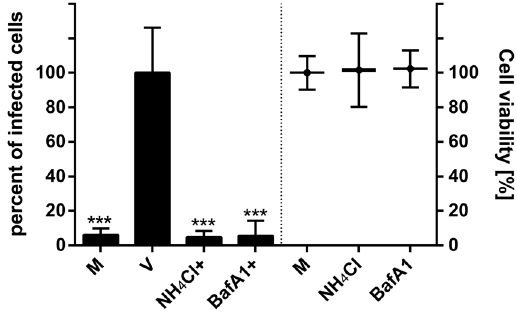
Figure 1. Inhibition of endosomal acidification with NH 4 Cl or bafilomycin A1 inhibits HCoV-OC43 infection in HCT-8 cell line. The infection efficiency determined with flow cytometry is expressed as the percentage of HCoV-OC43 infected cells, compared to the untreated control, and is presented on the left side of the graph. Right part of the graph shows the cell viability, as determined with an XTT assay. NH 4 Cl − 50 mM NH 4 Cl; BafA1 − 2.5 nM bafilomycin A1; control – PBS; M – mock infected cells; V or + − HCoV-OC43 infected cells. The data is presented as the mean of a triplicate for each sample ± SD. To determine the significance of differences between compared groups, Single-Factor Analysis of Variance (ANOVA) was applied. *** P values < 0.05 were considered